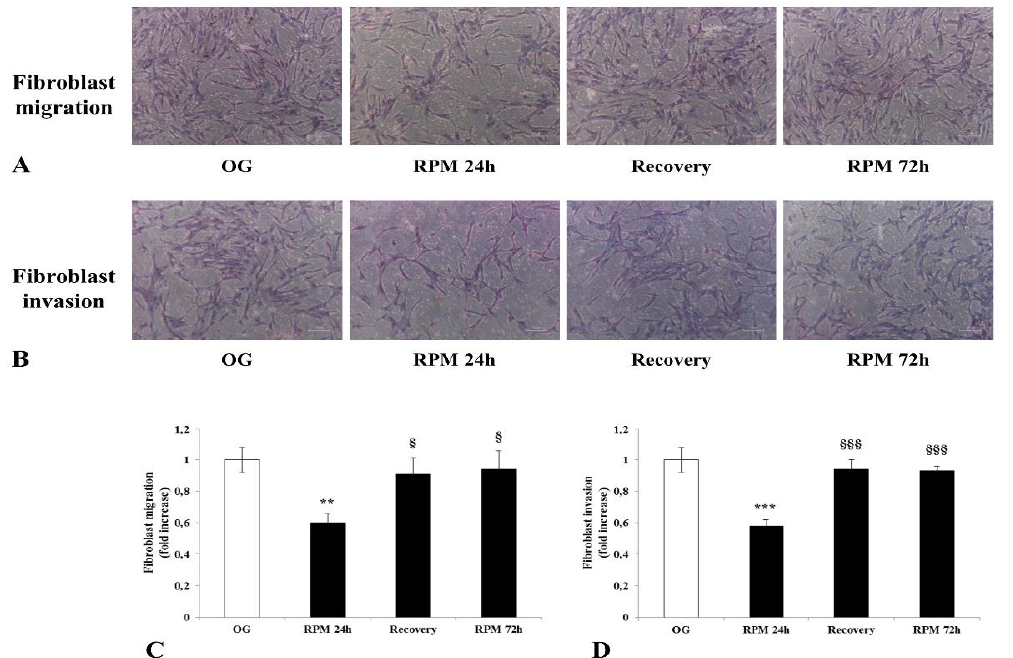
Figure 4. Effect of simulated microgravity on the migration ( A , C ) and the invasion ( B , D ) of human dermal fibroblasts. Transwell migration and invasion assays were performed on human fibroblasts exposed to the RPM for 24 h, 72 h, and after recovery experiments. Images were obtained by optical microscopy with 100× magnification. Values are expressed as a fold increase of on-ground control (OG). Each column represents the mean value ± SD of four independent experiments performed in duplicate with SD represented by vertical bars. ** p < 0.01; *** p < 0.001 versus OG; § p < 0.05; §§§ p < 0.001 versus RPM 24 h by ANOVA followed by Bonferroni post-test.